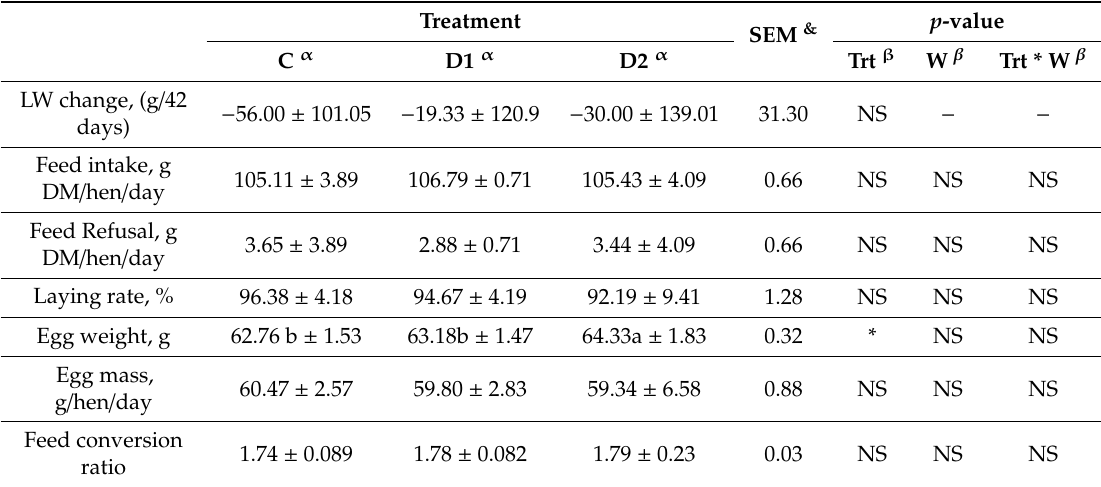
Table 2. E ff ect of spirulina on hens’ live weight changes and laying performances.